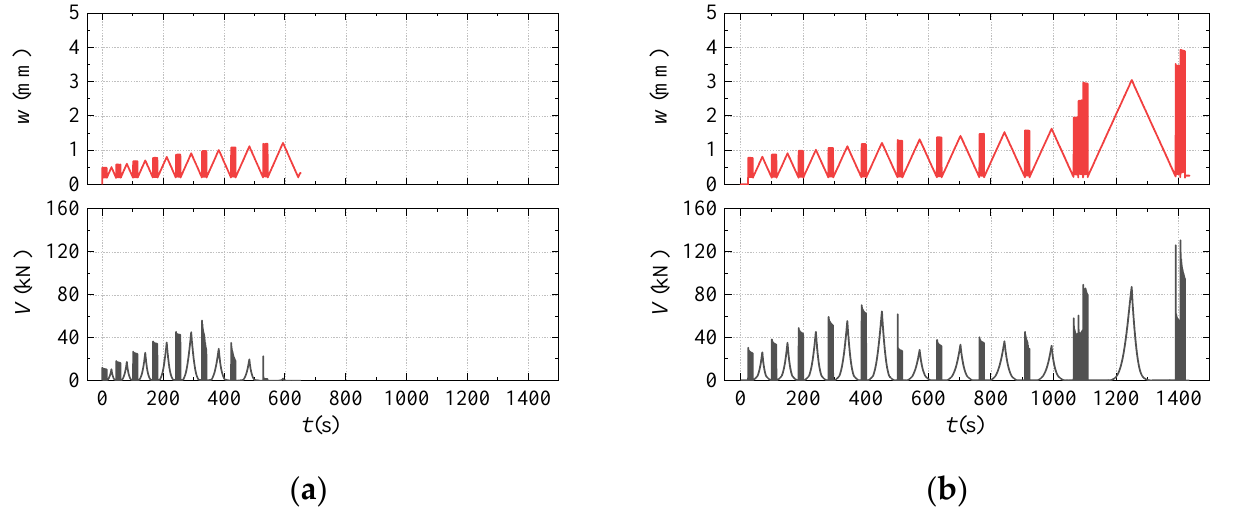
Figure 11. w - t and V - t plots of the CDS test for typical specimens: ( a ) Specimen CDS-II-1; ( b ) Speci- men